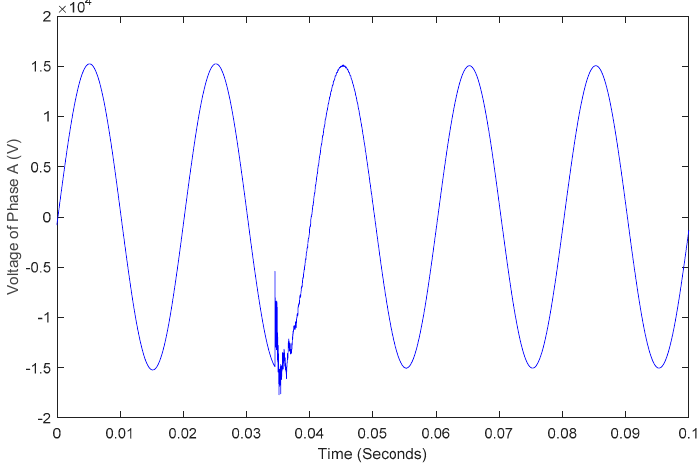
Figure 5. The recorded faulty phase voltage at the beginning of the feeder (in 21.06 km). Table 3. The error percentage of different faults at various resistances.